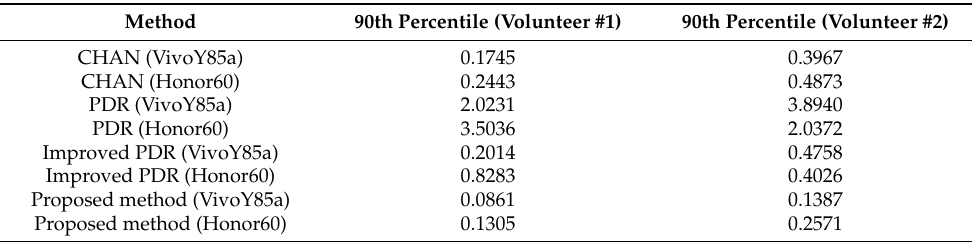
Table 6. The CDF of localization error with Honor60, VivoY85a, and two different height pedestrians in the second scene (m).